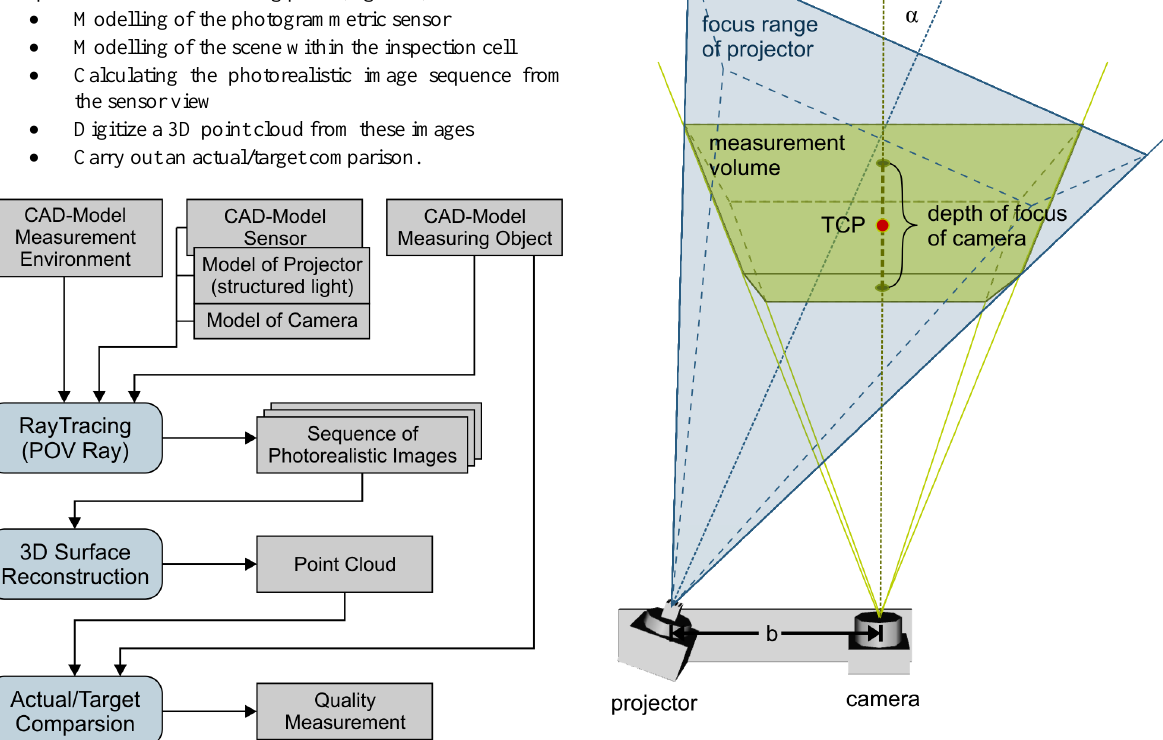
Figure 2. Simulation concept Figure 3. Sensor with measurement